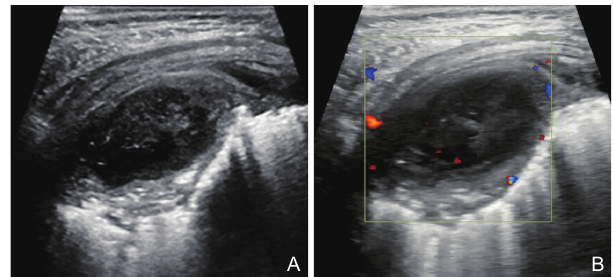
Figure 6 Pulmonary abscess sonograms. (A) Consolidated lung tissue showed a liquid dark area echo; (B) There was no blood flow signal in